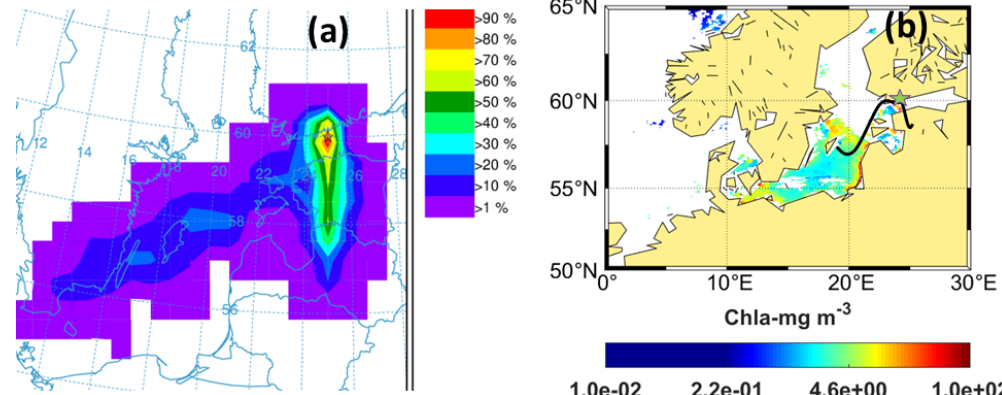
Figure 9. (a) Trajectory frequency plot (100ma.g.l., arrival time of trajectories at the measurement site: 22:00) for 24h back trajectory using GDAS meteorological input data (frequency grid resolution: 1 . 0 ◦ × 1 . 0 ◦ ). (b) Chl a concentrations (GlobColour level 3). Black line shows the trajectory direction, and the star point denotes the measurement